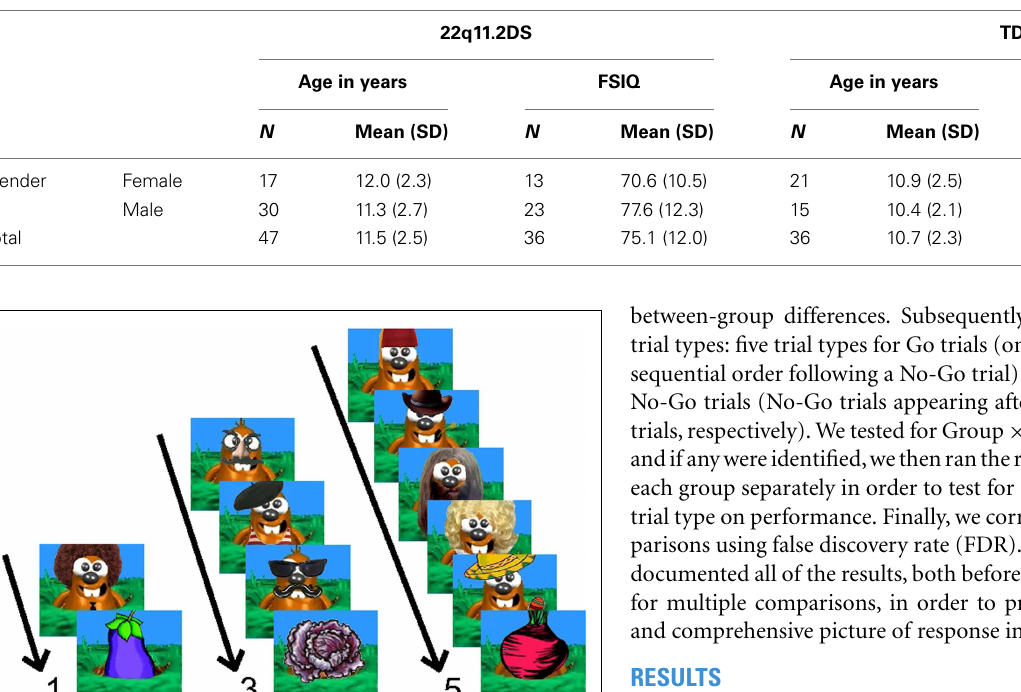
Table 1 | Demographic data on children with 22q11.2DS andTD children.